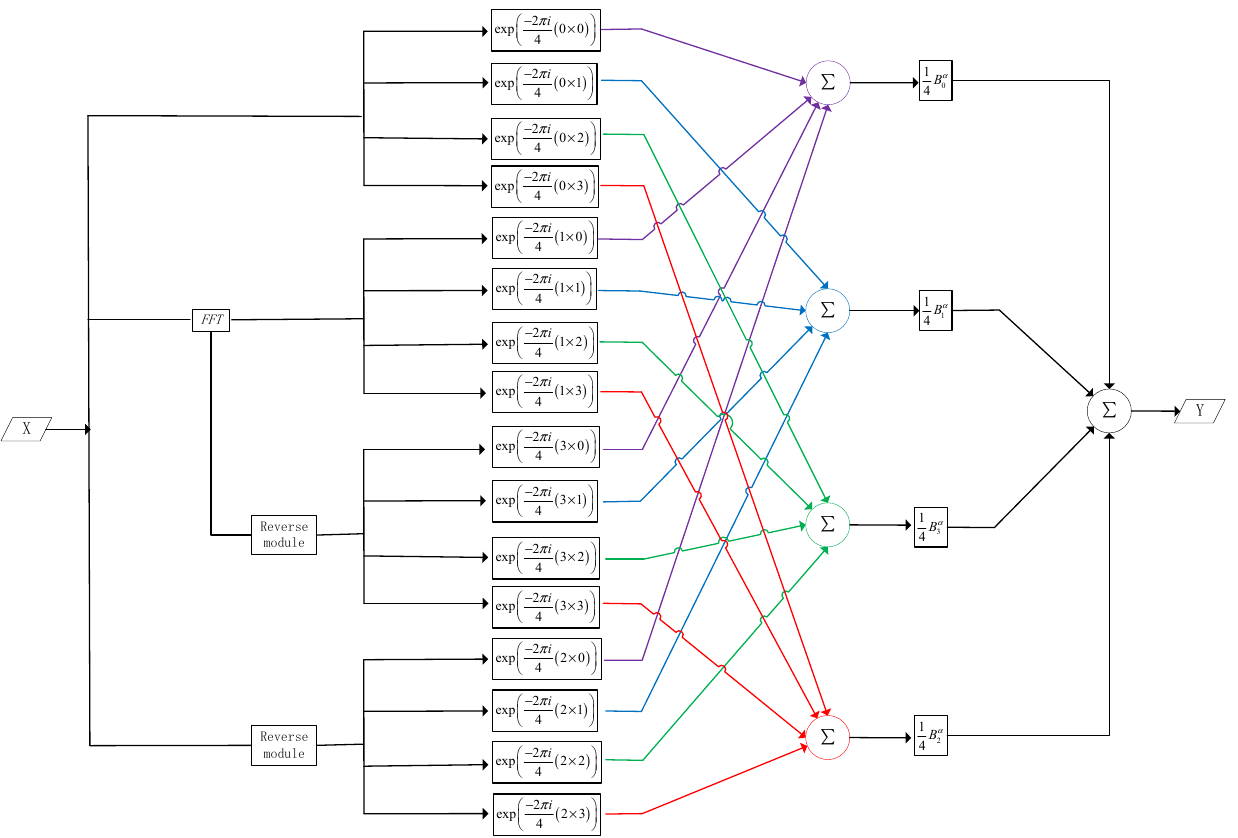
Figure 3. The reformulation of the WFRF T module.